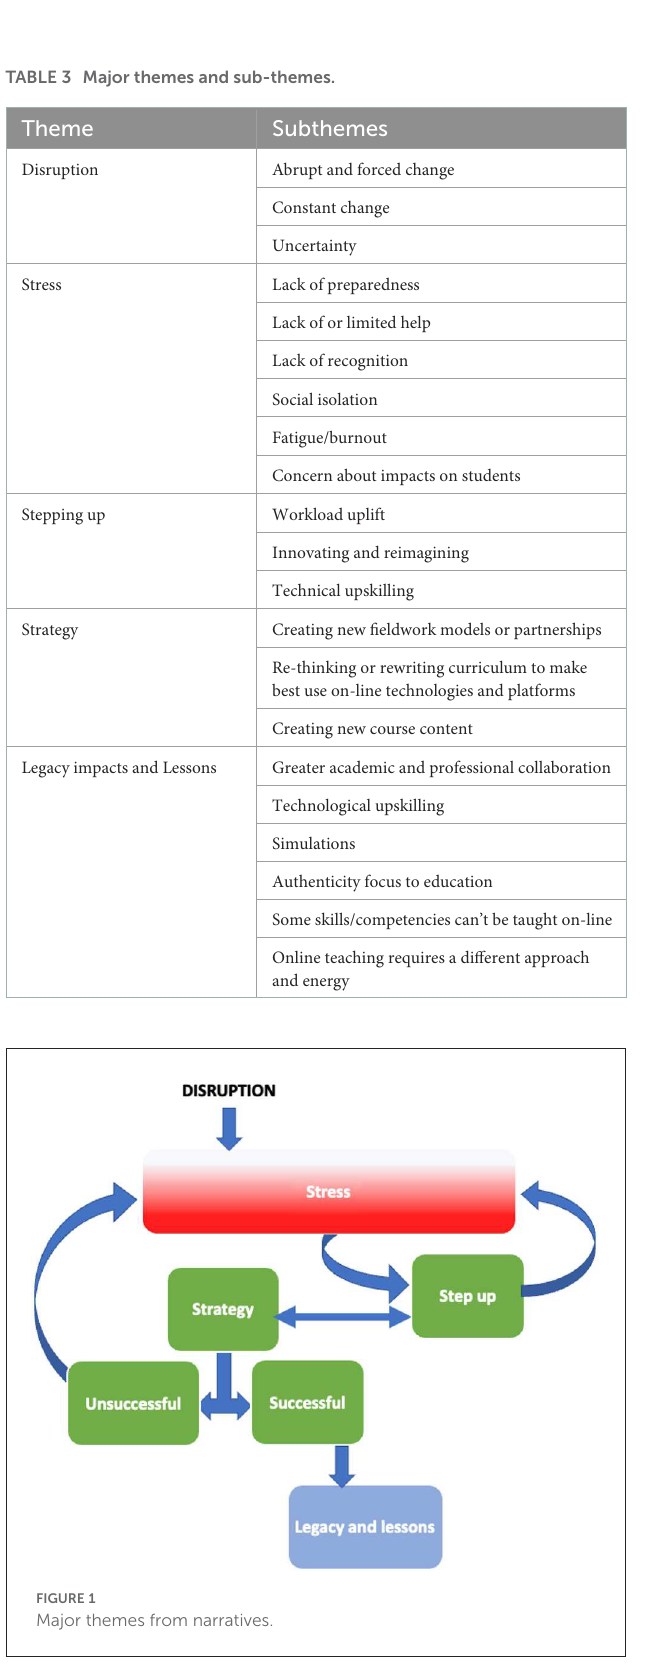
major changes to the way educators felt, practiced and adapted (professionally and personally). This disruption appears to have resulted in sustained changes to work and academic